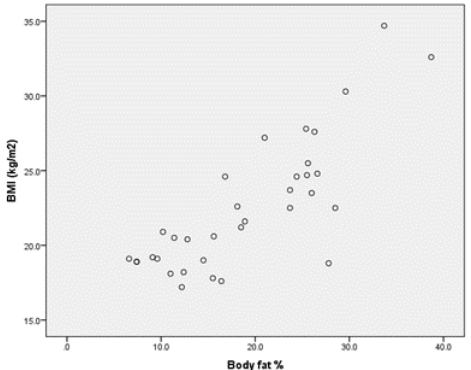
Figure 3. Correlation between BMI and body and fat % for the group of boys MID.